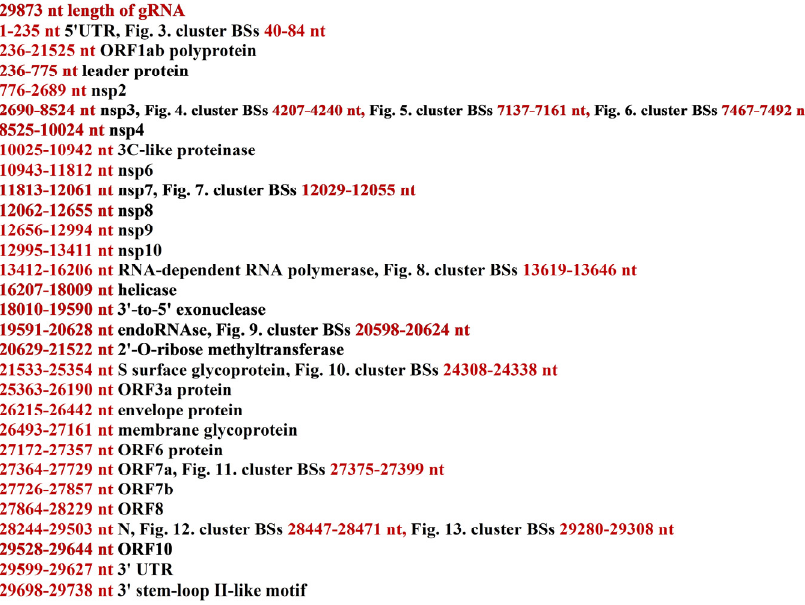
Figure 1. Nucleotide sequences of piRNA BSs in the 3 ′ UTR of mRNA and nucleotide sequences of piRNAs. Note: The nucleotides of piRNAs forming canonical and non ‐ canonical pairs with mRNA are highlighted in green and blue, respectively.